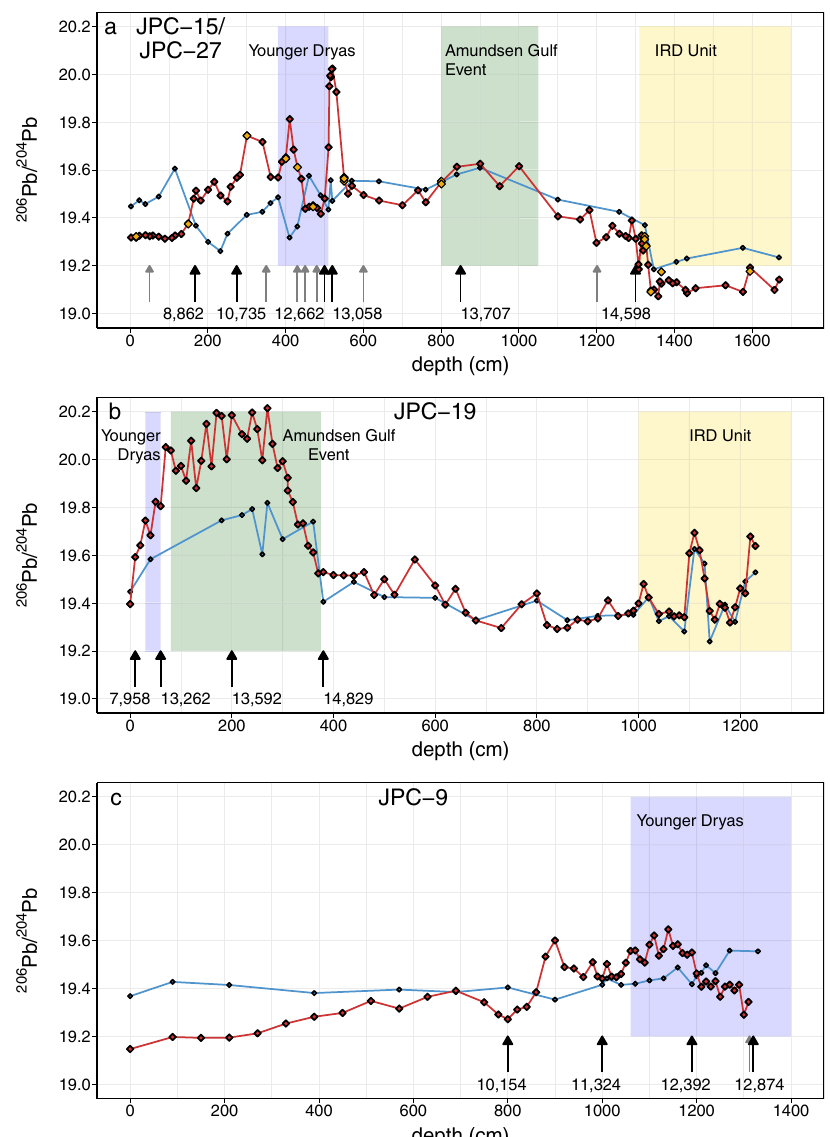
Fig. 2 Pb isotopic signatures of Beaufort Sea sediment cores. Authigenic (red) and detrital (blue) Pb Isotope records ( 206 Pb/ 204 Pb) for sediment cores JPC-15/27 ( a ), JPC-19 ( b ), and JPC-9 ( c ). Replicated authigenic compositions in ( a ) are shown as orange diamonds. Arrows (gray and black) indicate radiocarbon ages. Colored areas depicts the timing of major intervals explained in the discussion. The IRD Unit was de fi ned by Klotsko et al. (2019) 26